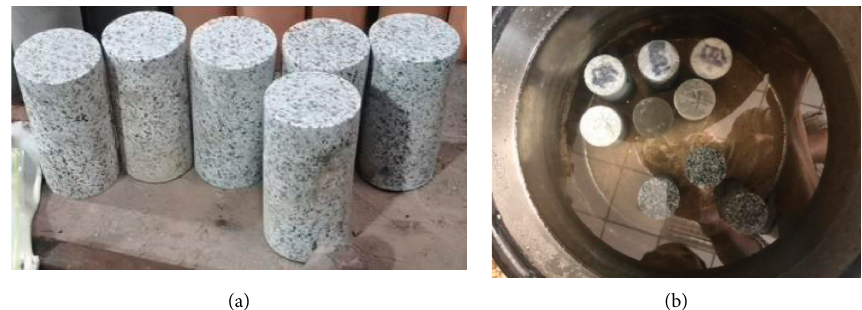
Figure 2: Processing of the specimen. (a) Granite specimen. (b) Granite specimen soaked to saturation.